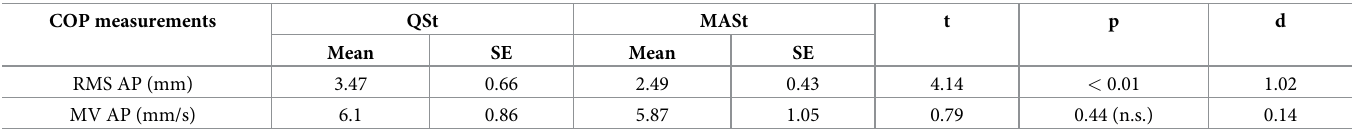
Table 1. Mean values and standard errors of COP measurements in the quiet standing (QSt) and standing with mental arithmetic (MASt) conditions. COP measurements QSt MASt Mean RMS AP